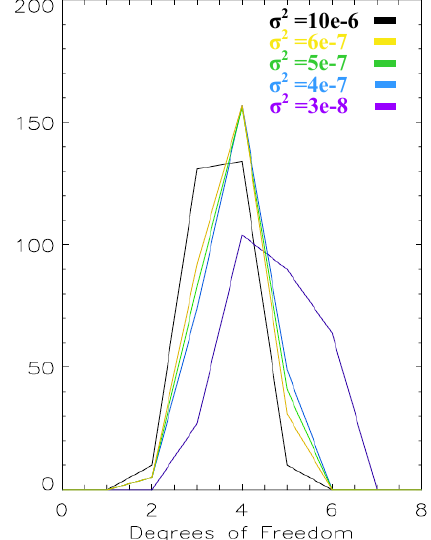
Fig. 5a Weights for the first and second eigenvalue component for 40 aerosol mixtures for all measurement scenarios. Retrieval scenarios with the same parameters but with varying optical depth are connected with solid lines. The domain of diesel and biomass burning (red) overlaps with the domains of polluted aerosol (dark blue and violet). Other domains: maritime (light blue), continental (black) and desert dust (sienna) are distinguishable from one another.